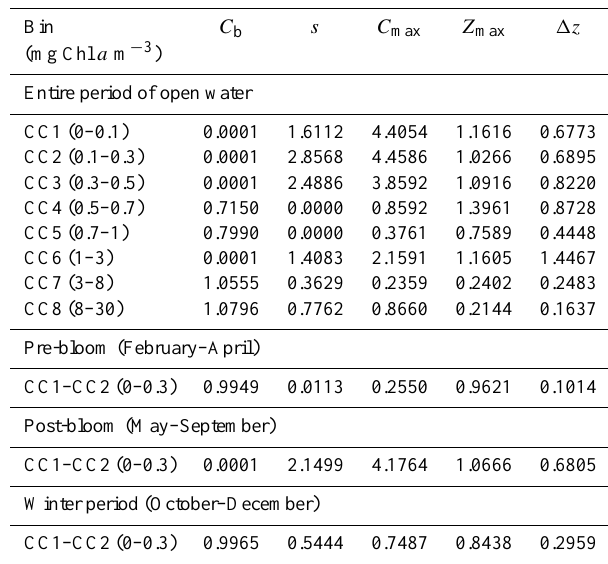
Table 5. Estimated values of the five parameters of Equation 1, ob- tained for the average dimensionless combined vertical profiles of chlorophyll a (CC1–CC2) during different time periods (i.e., pre- bloom, post-bloom, winter) and for the average dimensionless ver- tical profiles of chlorophyll a (CC1–CC8) during the entire period of open water at shallow ( ≤ 50m) Arctic